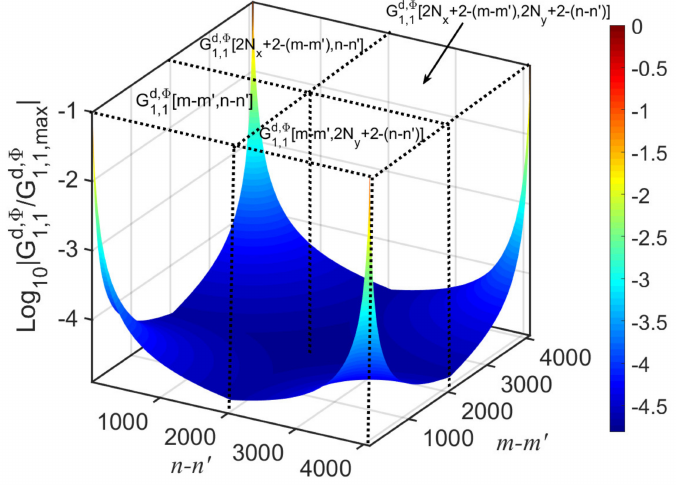
Figure 5. Values of Log 10 | G 1,1d, Φ [ m − m (cid:48) , n − n (cid:48) ] / G 1,1,maxd, Φ | given by (12) and (13). The results are obtained at 10.4 GHz. Similar results are obtained for G 1,1d,A [ m − m (cid:48) , n − n (cid:48)